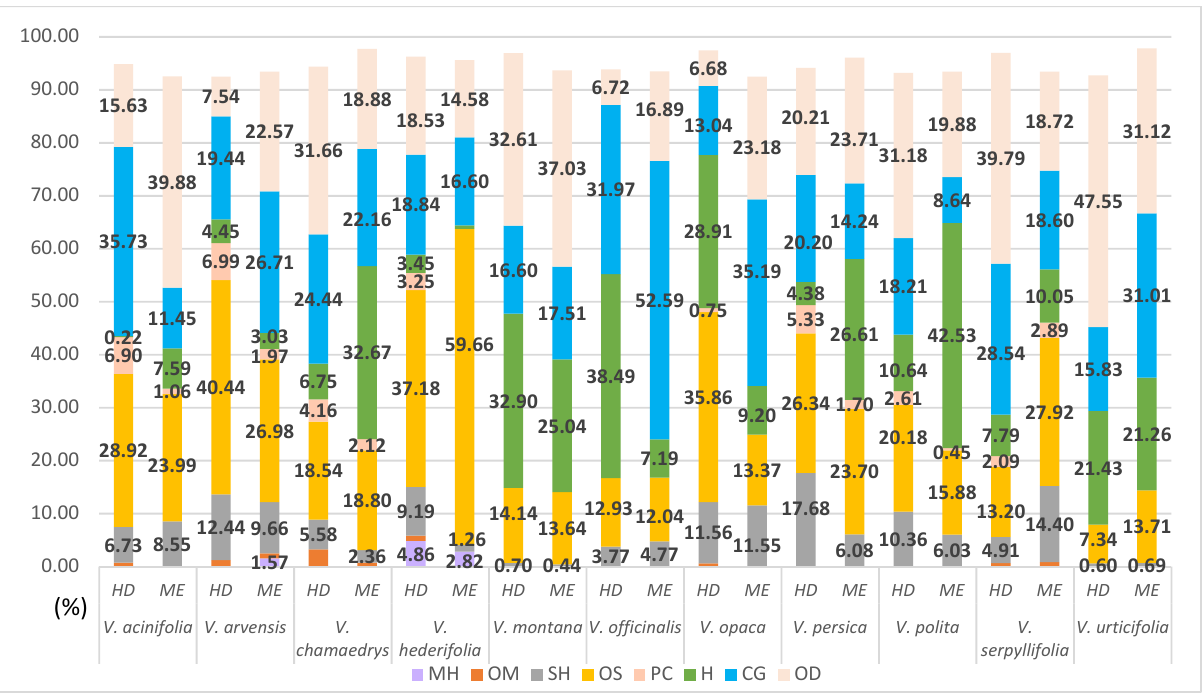
Figure 6. Relative content of volatile compounds in Veronica species collected from moderate habitats. MH, monoterpene hydrocarbons; OM, oxygenated monoterpenes; SH, sesquiterpene hydrocarbons; OS, oxygenated sesquiterpenes; PC, phenolic compounds; H, hydrocarbons; CG, common group of acids, alcohols, and esters; OD, oxygenated diterpenes.